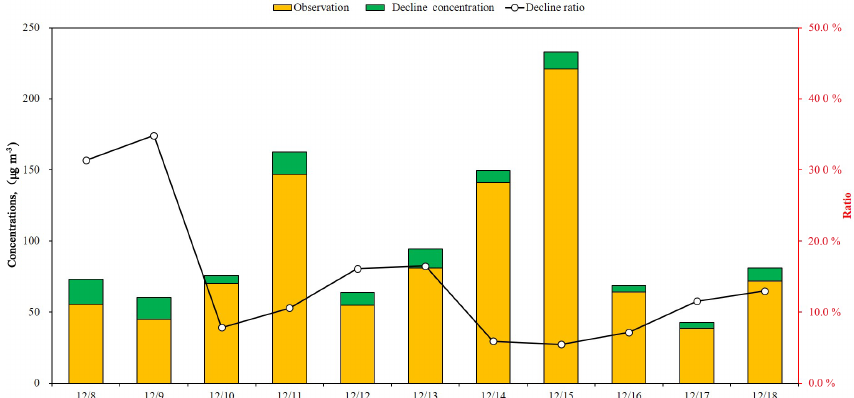
Figure 14. Percentage reduction in PM 2 . 5 resulting from the control measures.